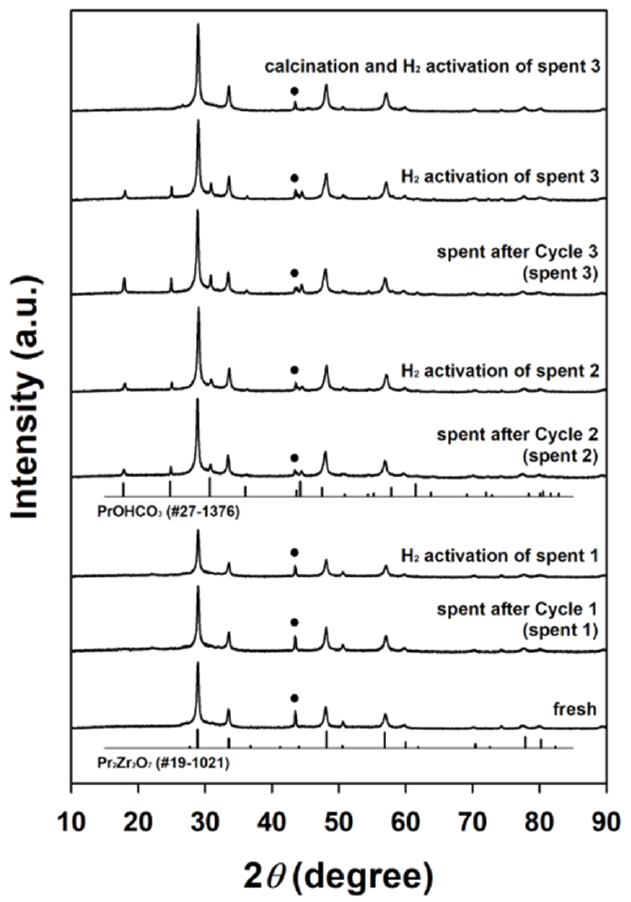
Figure 11. XRD of the fresh and spent catalyst of 5 wt % Cu/Pr 2 Zr 2 O 7 in recycle runs. The symbol represents the diffraction peak of Cu (111) and the bar plots are the representative reference XRD patterns of PrOHCO 3 and Pr 2 Zr 2 O 7 .